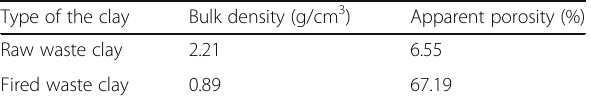
Table 2 Densification parameter of the fired samples at 1100 °C Type of the clay